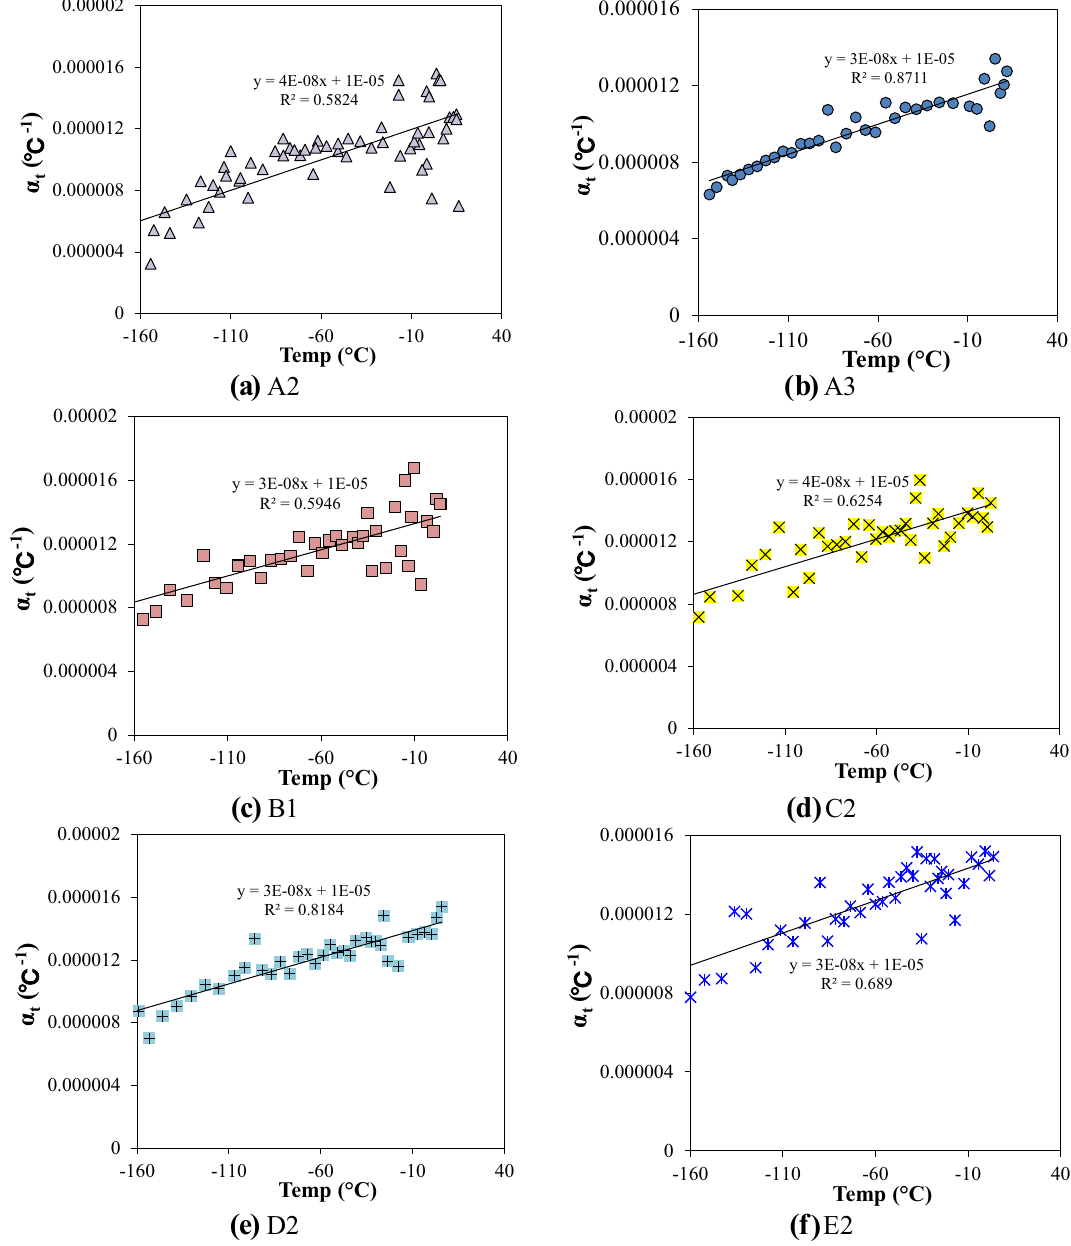
Fig. 5 Scatters of transit linear expansion coefficient versus temperature